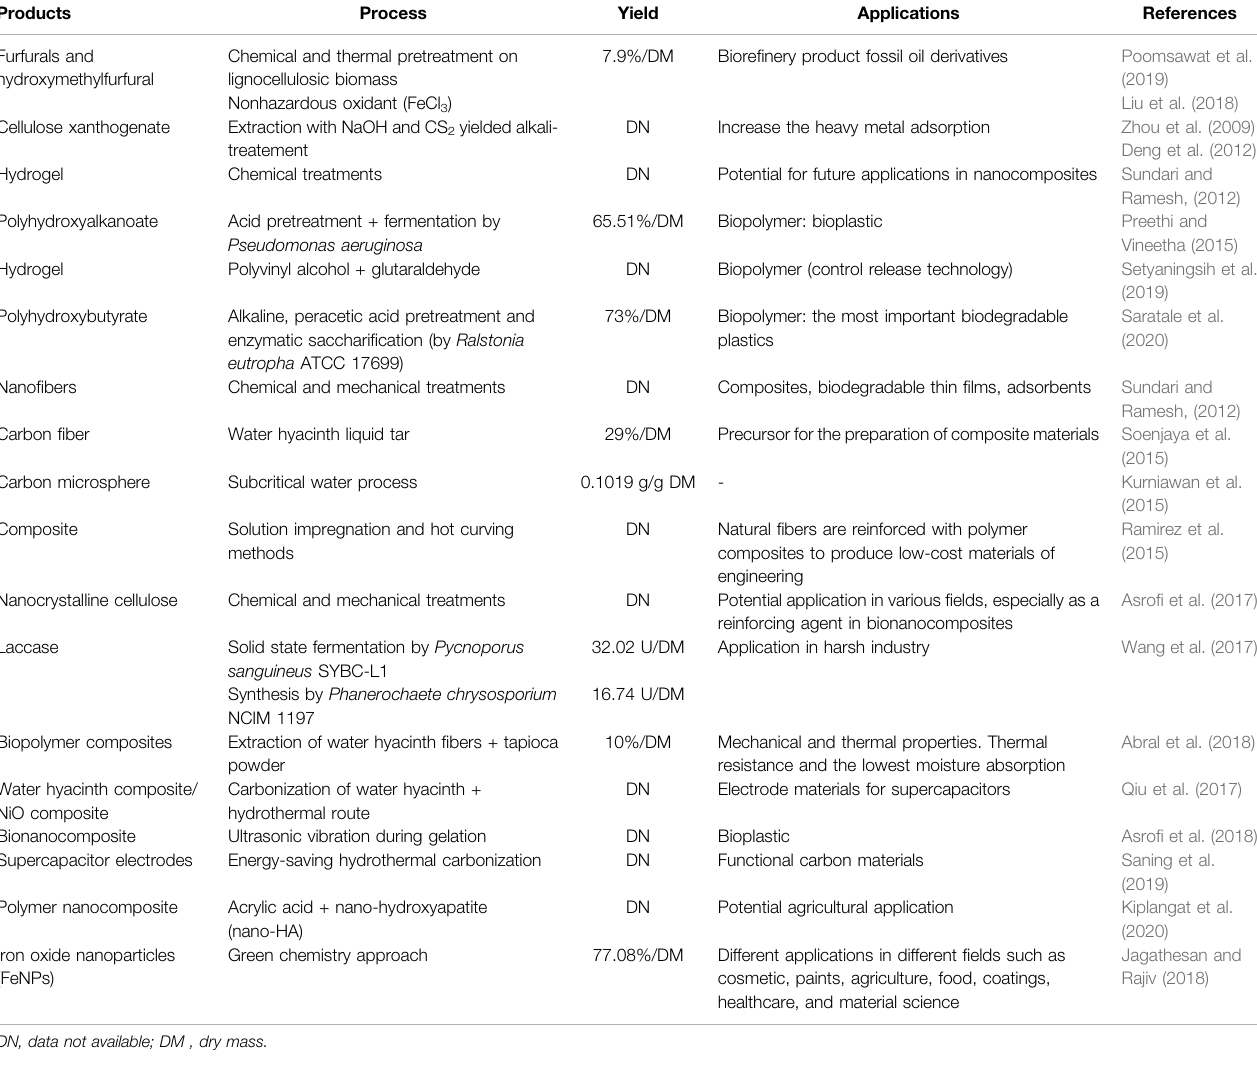
TABLE 1 | Value-chemicals produced from E. crassipes and their applications.